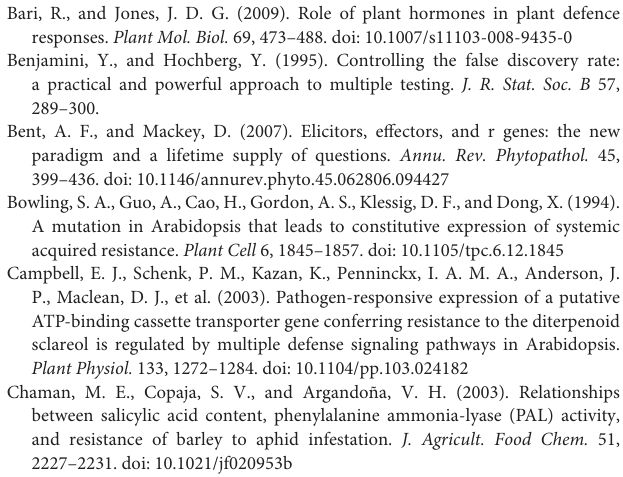
Table S4 | List of the gene IDs and their functional descriptions from two detailed gene clustering analyses. Table S5 | Eighty genes with particular expression patterns in the treated rice and low or undetected expression in the control rice. Gene IDs with bold fonts were selected for qRT-PCR